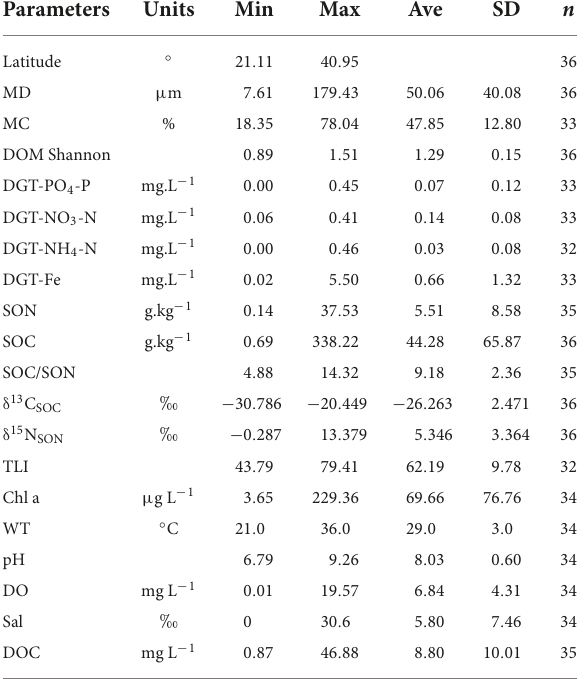
TABLE 1 Physicochemical parameters and DOM α -diversity index of surface sediments and overlying water in China’s coastal wetlands. Parameters Units Min Max Ave SD n